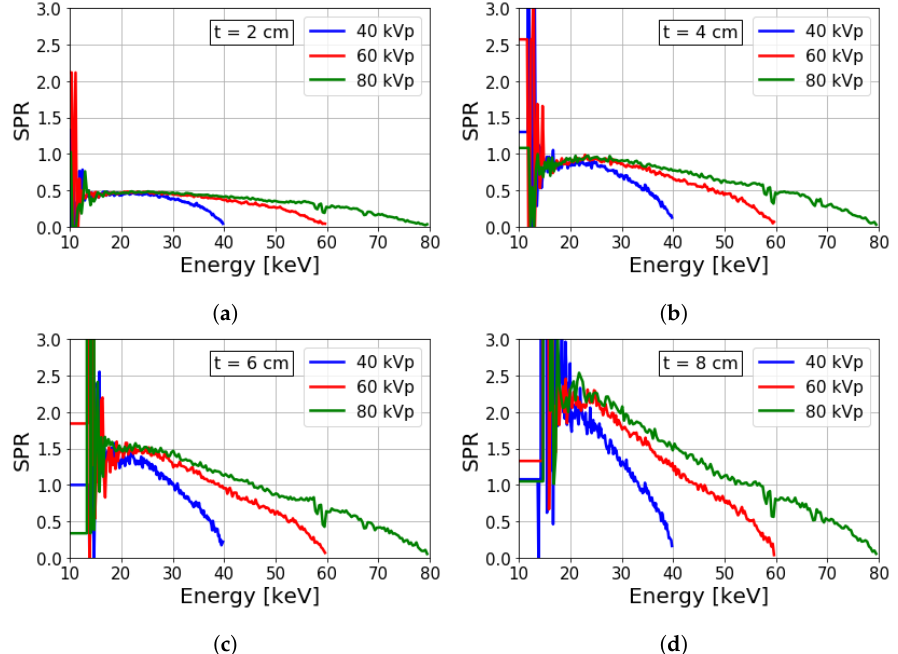
Figure 5. Spectrally-resolved SPRs from simulation using a 0.5 cm air gap for different kVps and object thicknesses of ( a – d ) 2, 4, 6, and 8 cm, respectively.